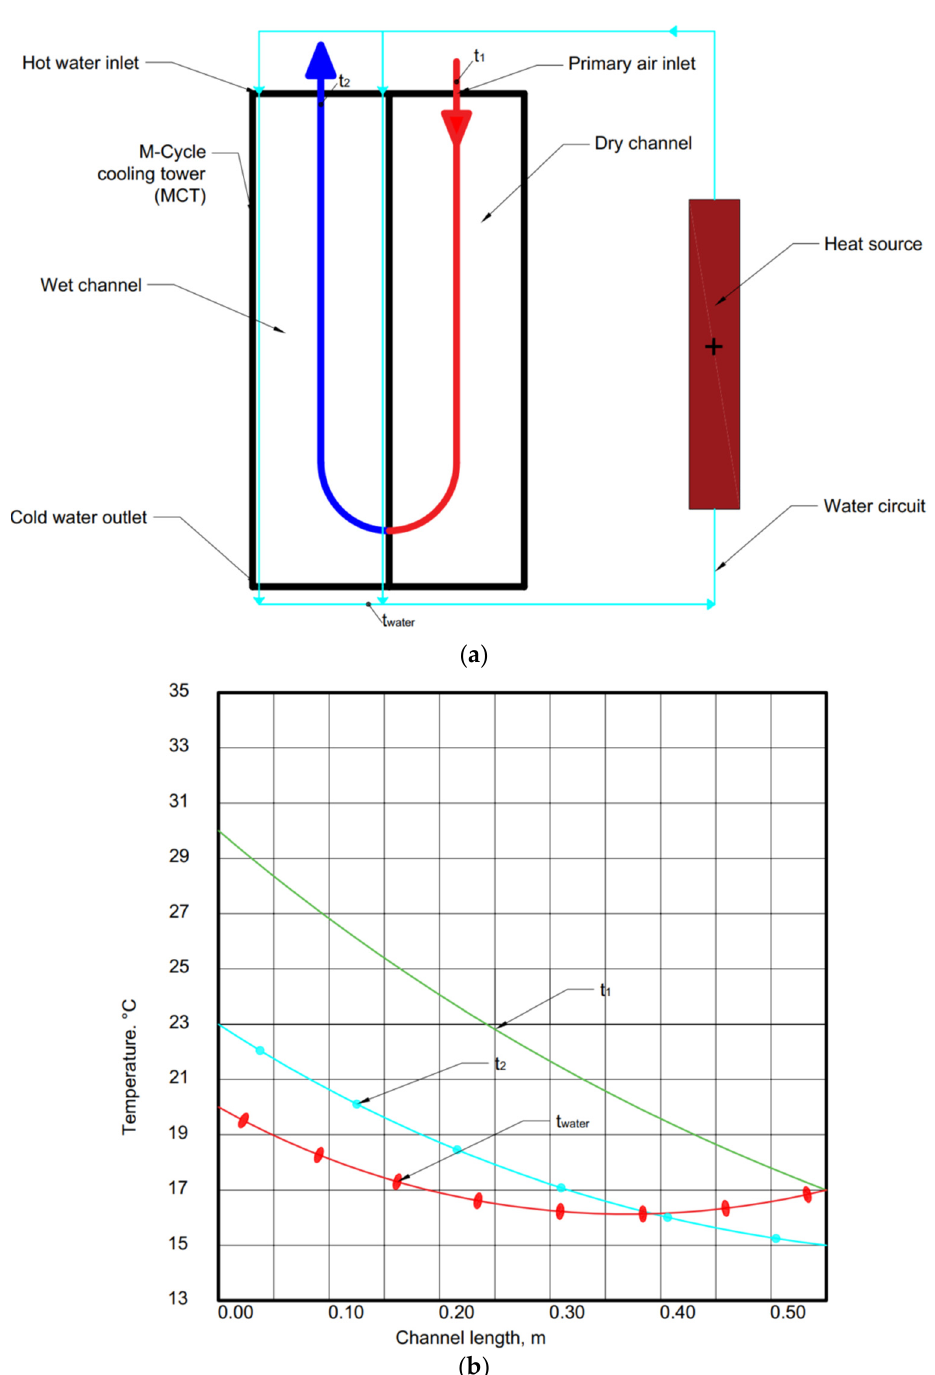
Figure 11. M-cooling tower: ( a ) diagram; ( b ) temperature distribution in the MCT [62]. The large-scale cooling tower used in most power plants around the world was investigated in [63]. It is clearly demonstrated that incorporating the M-cycle into a natural draft cooling tower (NDCT), which will involve small internal changes as shown in Figure 12, will increase the efficiency of power stations working in the Rankine cycle. Considering the dry-bulb temperature of +30 ◦ C, relative humidity of 35%, and the power station capacity of 500 MWt, the NDCT will reduce the water temperature from 38 ◦ C to 24 ◦ C. The water outlet temperature can be reduced to approx. 13 ◦ C by using the Maisotsenko effect. Consequently, the water mass flow rate will be reduced by 44%, while the make-up water mass flow rate will be smaller by 20%